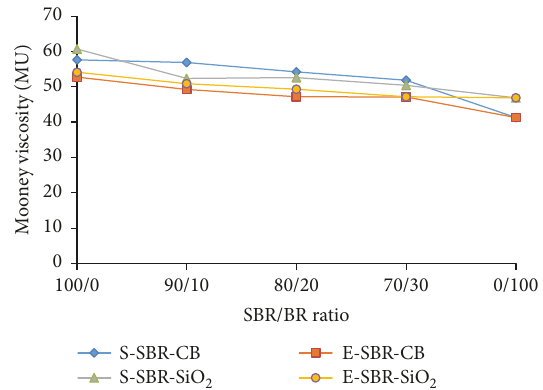
Figure 2: Cure time of the rubber compounds.